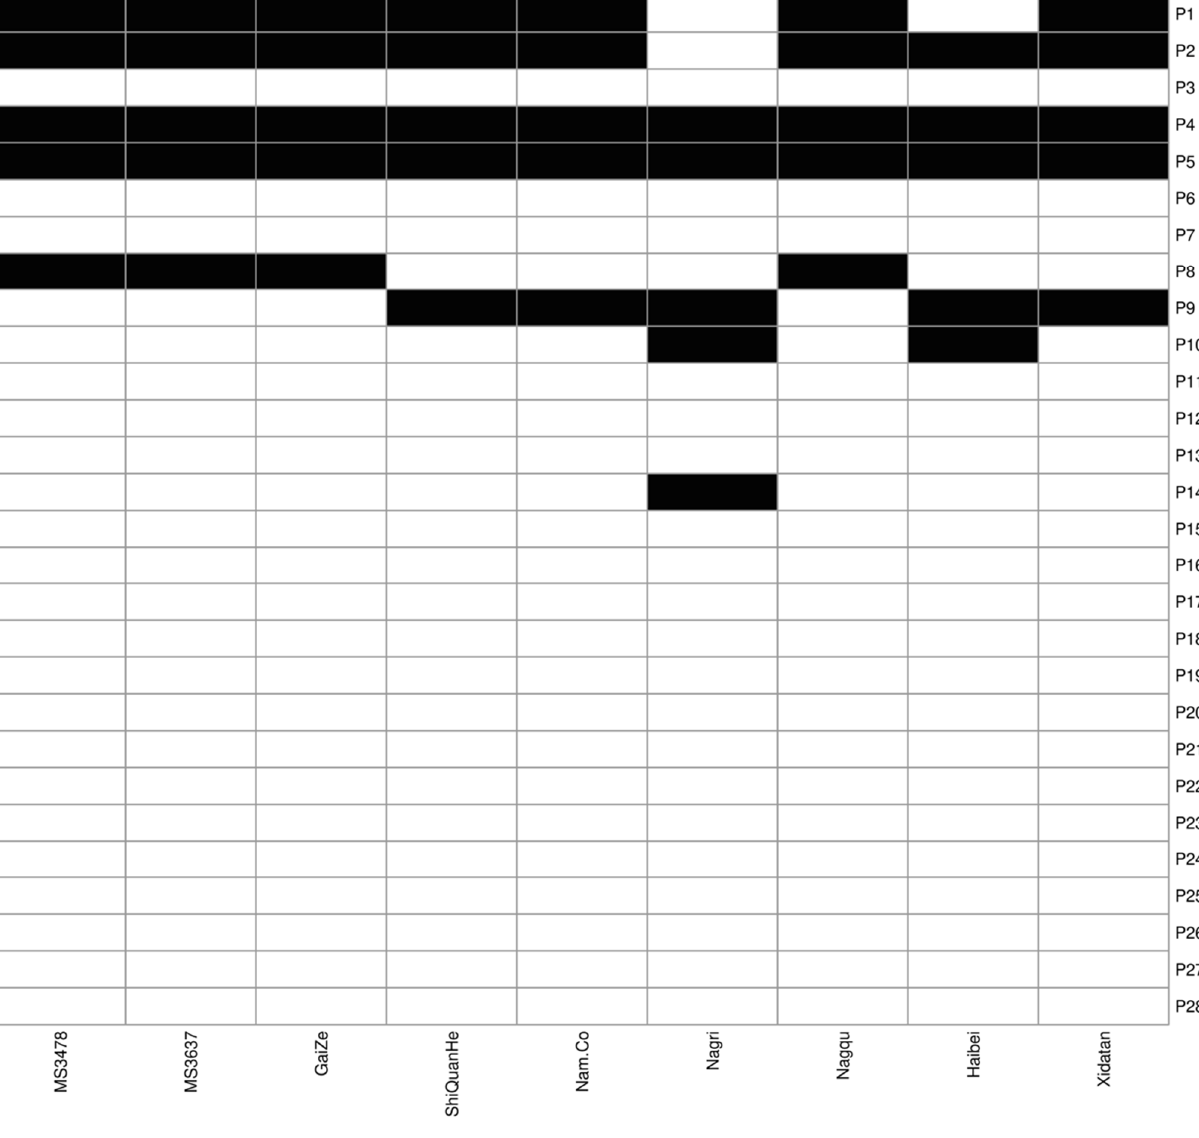
Figure 5. The sensitive parameter combination using the SA method based on CNOP-P over the TP (From research findings by Sun et al. [48]. Parameter corresponding to the number can be found in studies by Sun et al. [48] and Table S2 in Supplementary Materials).